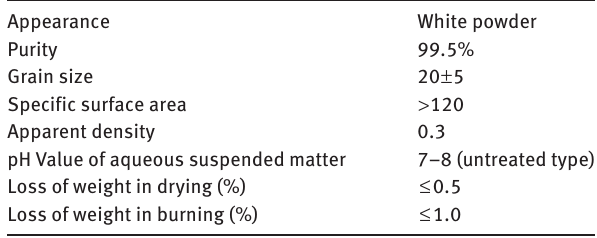
nanoparticles. 2